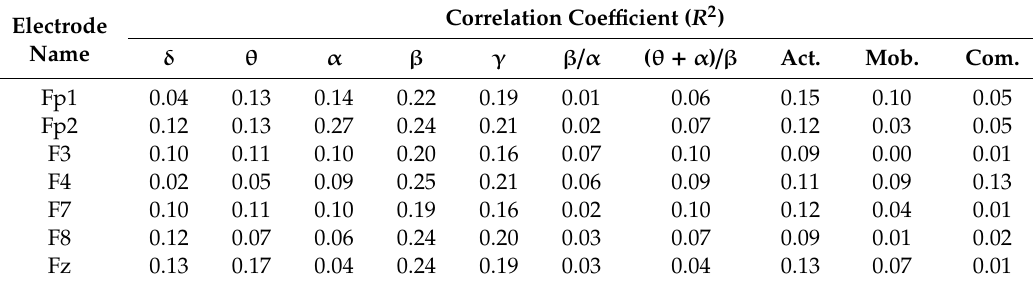
Table 2. Analysis of correlation between each parameter, and drowsiness condition represented by KSS (Karolinska sleepiness scale) for all electrode sites. Act: Activity, Mob: Mobility, Com: